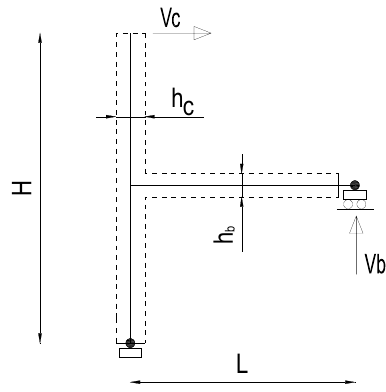
Figure 2. Scheme of the beam–column joint.